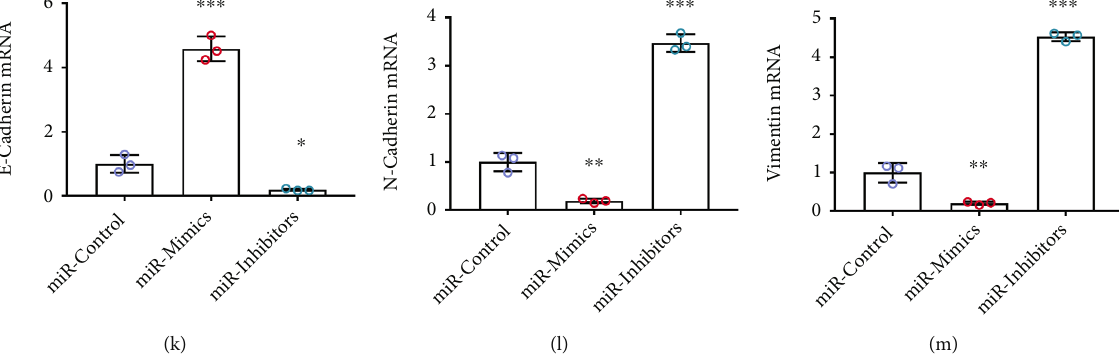
Figure 5: ALDH1A3 – Linc00284 axis mediated the expression of TGF β by sponging miR-361-5p. (a) Schematic diagram of the potential binding sites between Linc00284 and miR-361-5p. Dual-luciferase reporter assay (b) and RIP experiment (c) and (d) con fi rmed the interaction between Linc00284 and miR-361-5p. (e) and (f) The expression level of miR-361-5p in ALDH1A3- or Linc00284-silenced (e) and -overexpressed (f) SW480 cells. (g) Schematic diagram of the potential binding sites between 3'-UTR of TGF β mRNA and miR-361- 5p. (h) Dual-luciferase reporter assay con fi rmed the interaction between TGF β mRNA and miR-361-5p. The mRNA level in cells (i) and protein in medium (j) of TGF β in miR-361-5p mimics- or inhibitors-treated SW480 cells were examined by qPCR and ELISA, respectively. The mRNA level of E-Cadherin (k), N-cadherin (l), and Vimentin (m) in miR-361-5p mimics- or inhibitors-treated SW480 cells was examined by qPCR.